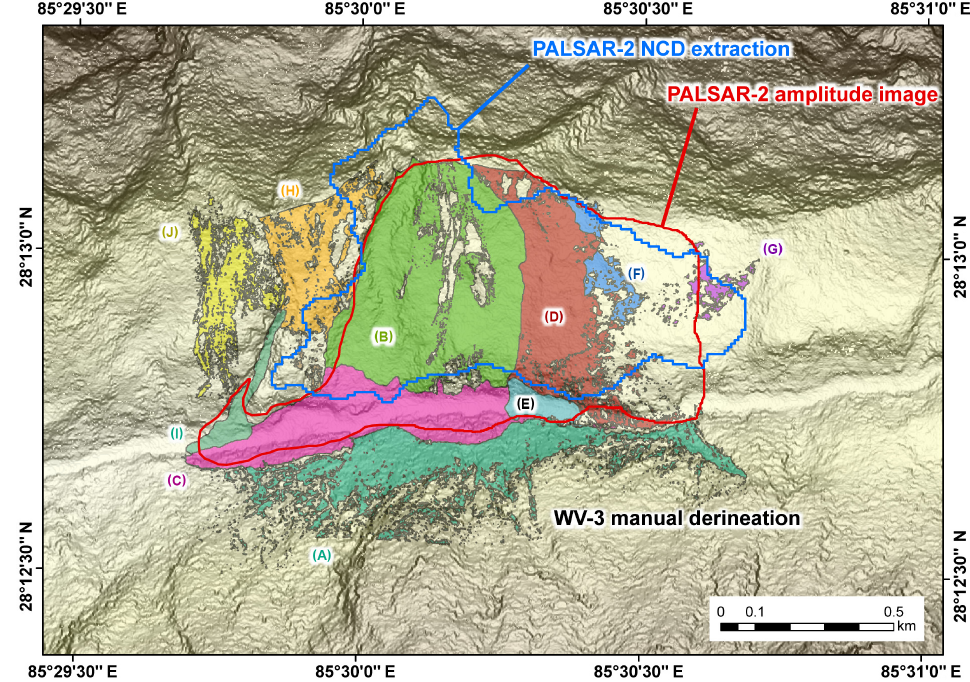
Figure 8. Sediment outlines delineated from PALSAR-2 data and WorldView-3 (WV-3) imagery. The background is hillshade imagery generated from the AW3D